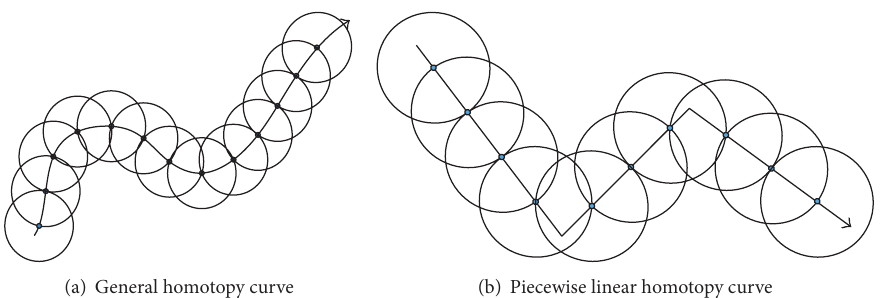
Figure 1: Solution curves with spheres